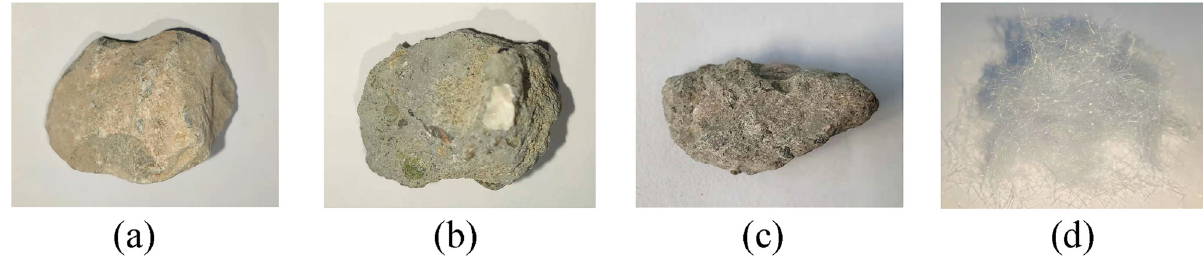
Figure 1: Appearance of coarse aggregate and PPF: ( a ) NCA, ( b ) RCA, ( c ) RCA - 20, and ( d ) PPF.